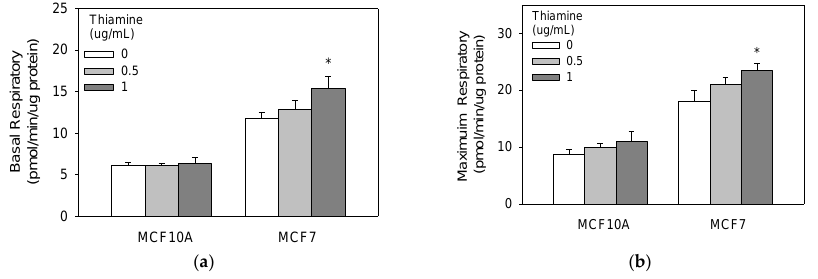
Figure 3. Thiamine increases baseline ( a ) and maximum ( b ) cellular oxygen consumption in breast cancer cells. Cells were treated with a range of thiamine doses for 24 h before subjecting them to a mitochondria stress test (Seahorse Bioscience, Billerica, MA). Results are expressed as mean ± SE (* significant difference relative to control—white bar (0 µ g/mL